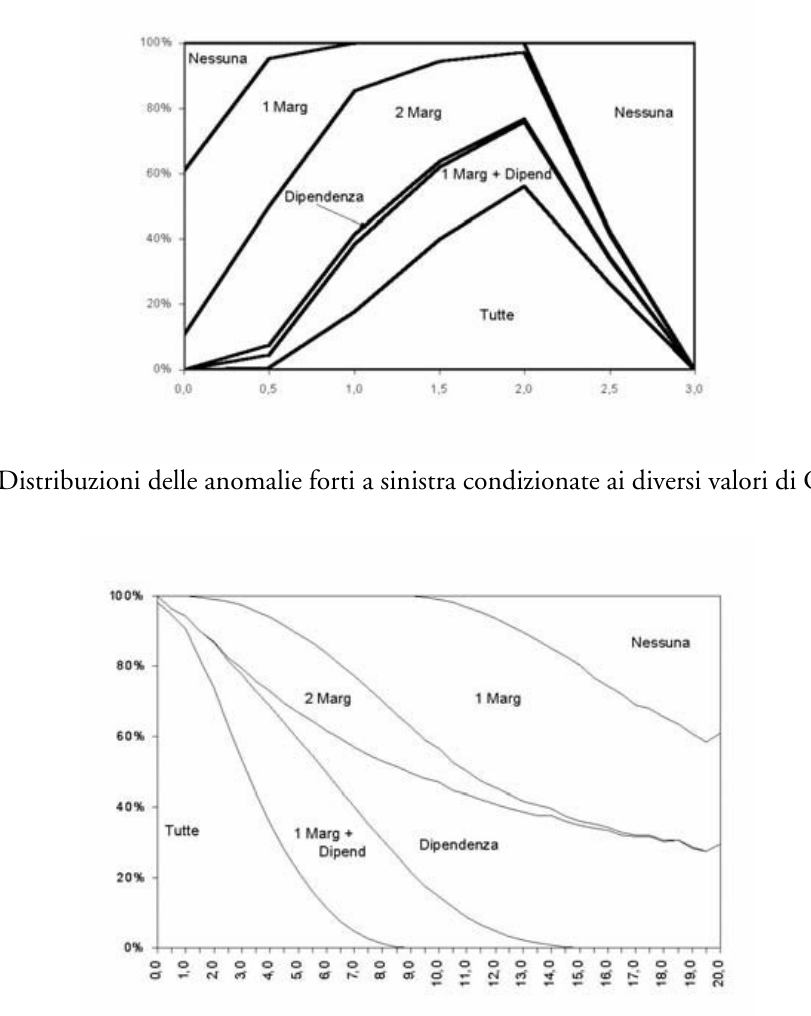
Figura 3 – Distribuzioni delle anomalie deboli condizionate ai diversi valori di G 2